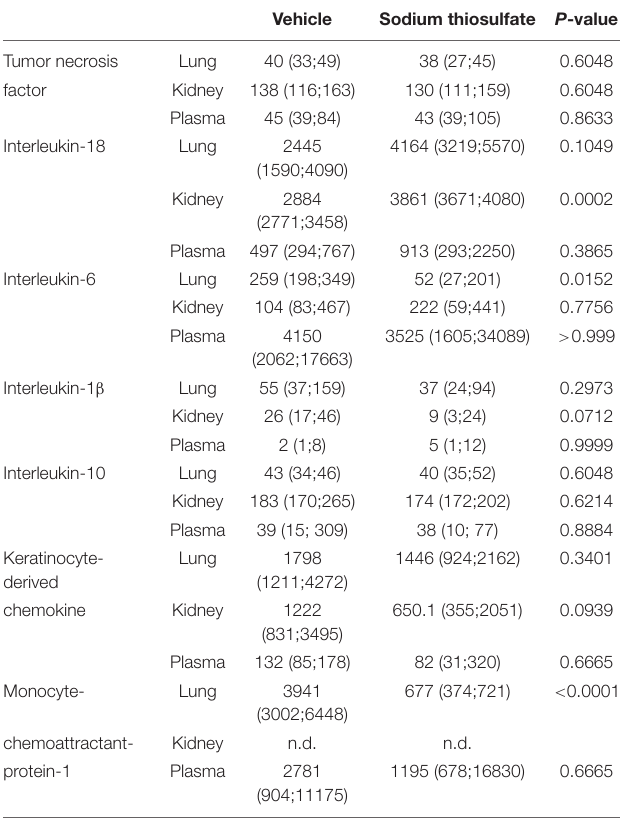
TABLE 3 | Terminal plasma (in [pg · mL) and tissue (kidney and lung, [pg · mg protein − 1 ]) cytokine and chemokine concentrations. Vehicle Sodium thiosulfate P -value